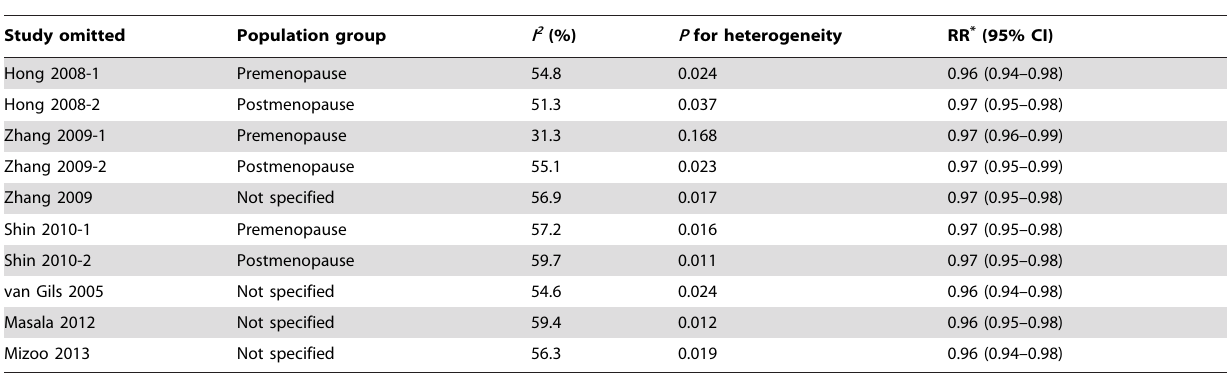
Table 2. Sensitivity analyses of included studies.